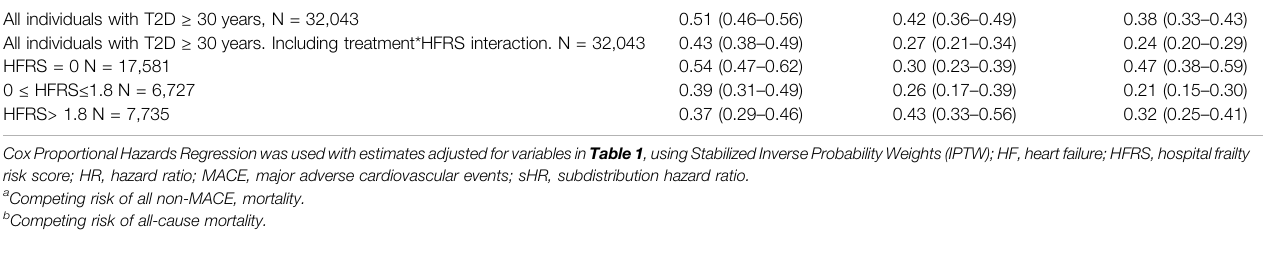
TABLE 2 | Rates of major adverse cardiovascular events, heart failure hospitalisation and all-cause mortality in patients with type 2 diabetes dispensed sodium glucose Cotransporter-2 inhibitors versus dipeptidyl Peptidase-4 inhibitors, strati fi ed by frailty status. Cohort MACE Heart Failure Hospitalization All-Cause Mortality sHR; 95% CI a All individuals with T2D ≥ 30 years, N =